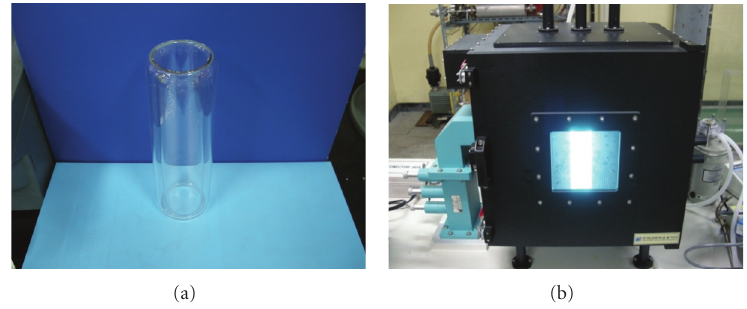
Figure 2: Snapshot of the double-tube-type MDEL (a) and microwave-discharged lamp set in the microwave oven